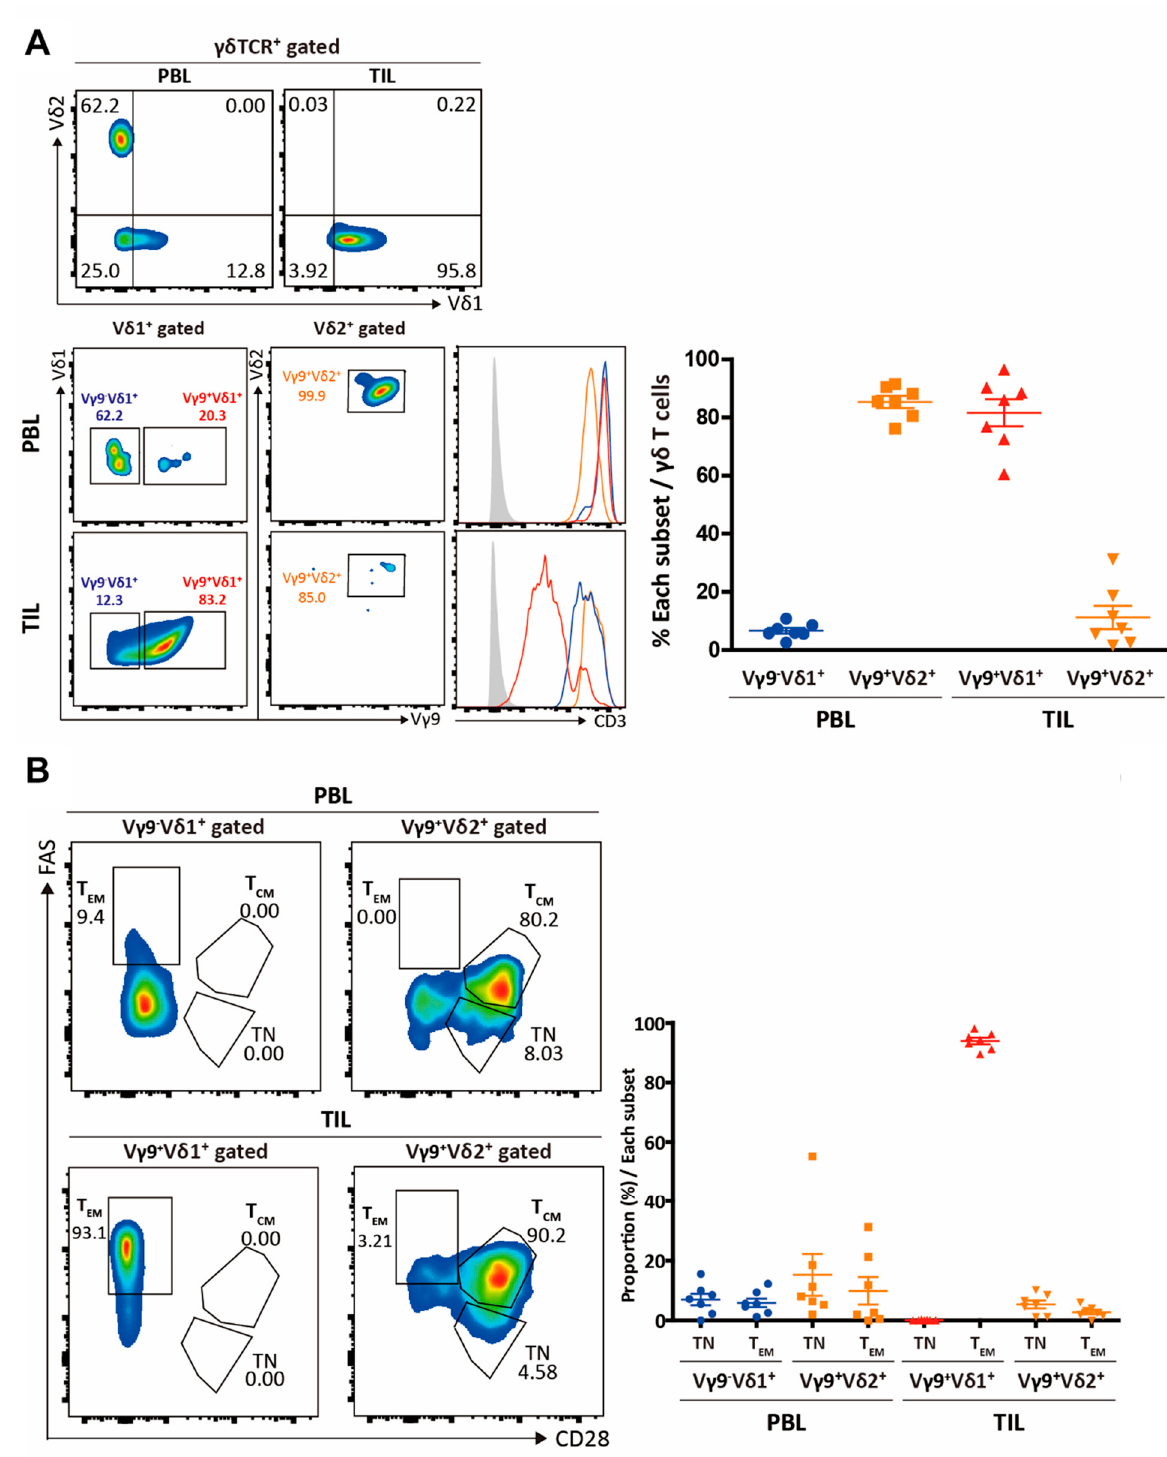
Figure 3. Identification of intra-tumoral CD3 low γδ T cells. ( A ) Peripheral blood lymphocytes (PBLs) and TIL γδ T cells were assessed for the expression of V δ 1 and V δ 2 chains, while gated V δ 1 and V δ 2 γδ T cells were analyzed for the expression of V γ 9 chain. The level of the CD3 expression is shown for V γ 9- δ 1+, V γ 9+- δ 1+, and V γ 9+- δ 2+ T cells. ( B ) Gated V γ 9+- δ 1+ and V γ 9+- δ 2+ T cells in PBLs or TILs were analyzed for FAS and CD28 to assess their differentiation statuses. In addition, up-regulation of both activation/exhaustion molecules suggested the potent anti-tumor cytotoxic activity of these V γ 9 δ 1 T cells (Figure 4A,B)